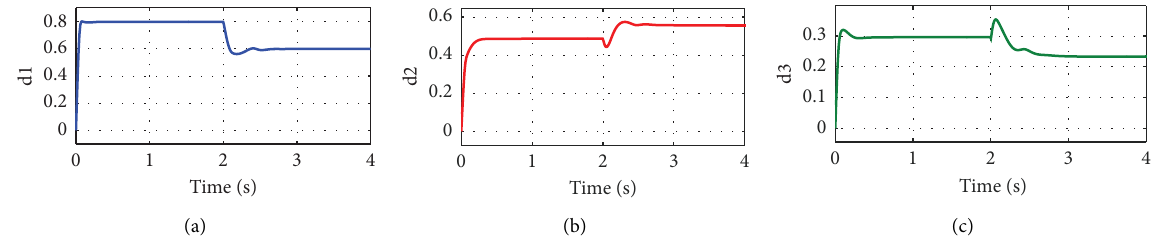
Figure 25: Duty cycles in the third operation mode. (a) Duty cycle of S1. (b) Duty cycle of S2. (c) Duty cycle of